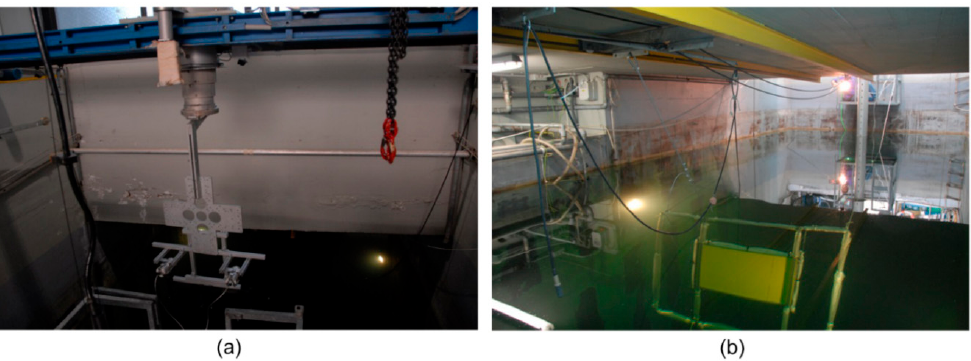
Figure 4. The telescopic pole for the handling of the opto-acoustic camera prototype ( a ). Conveyor belt system for the handling of the orientation fixture ( b ).